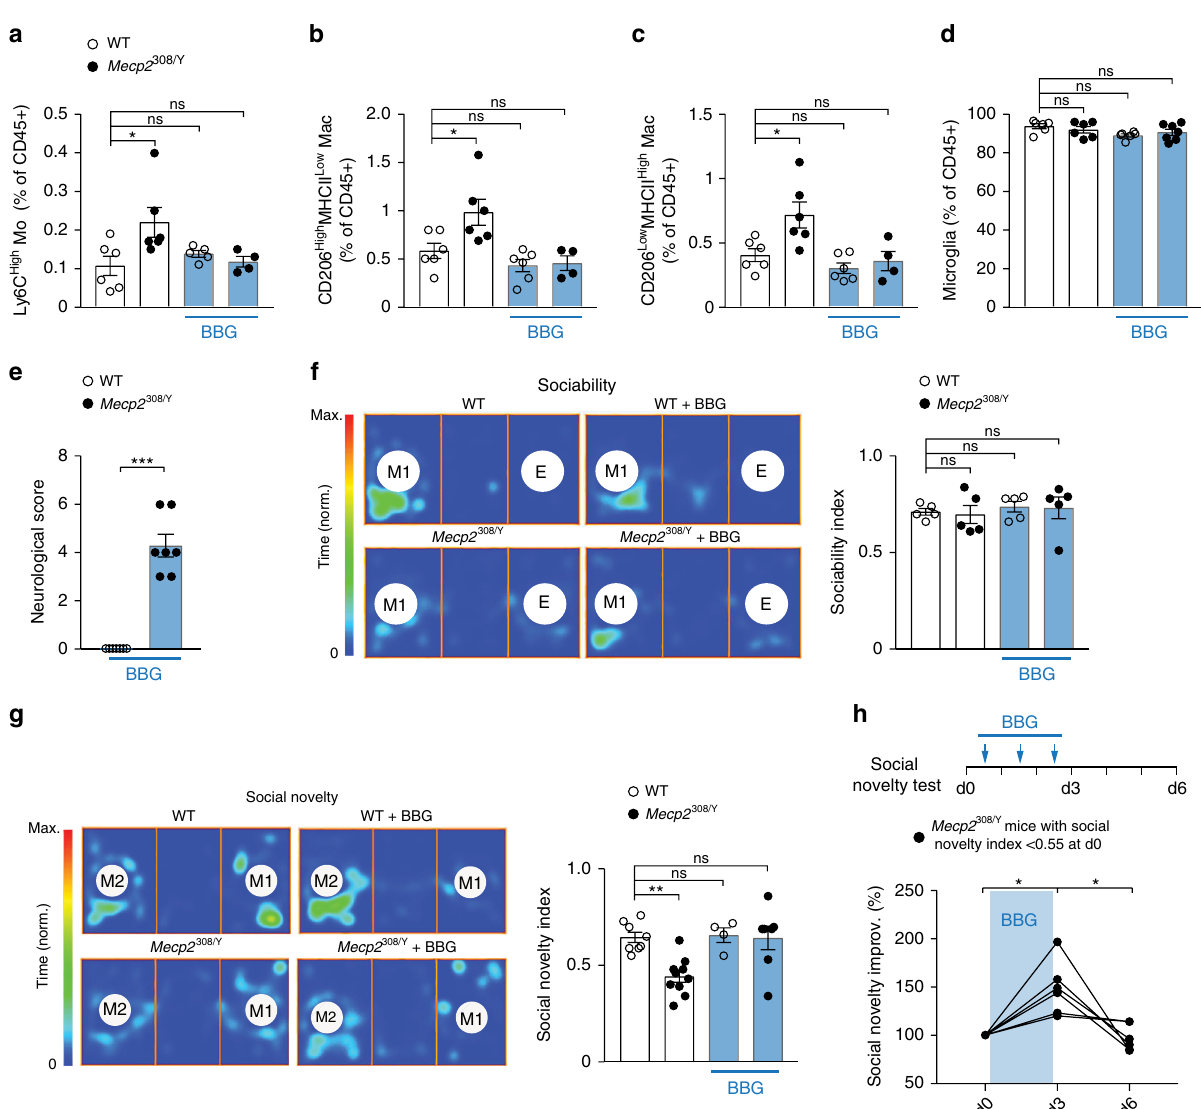
Fig. 6 Pharmacological inhibition of P2X7Rs reduces in fl ammation and improves social behavior. a Percentages of Ly6C High monocytes in WT and